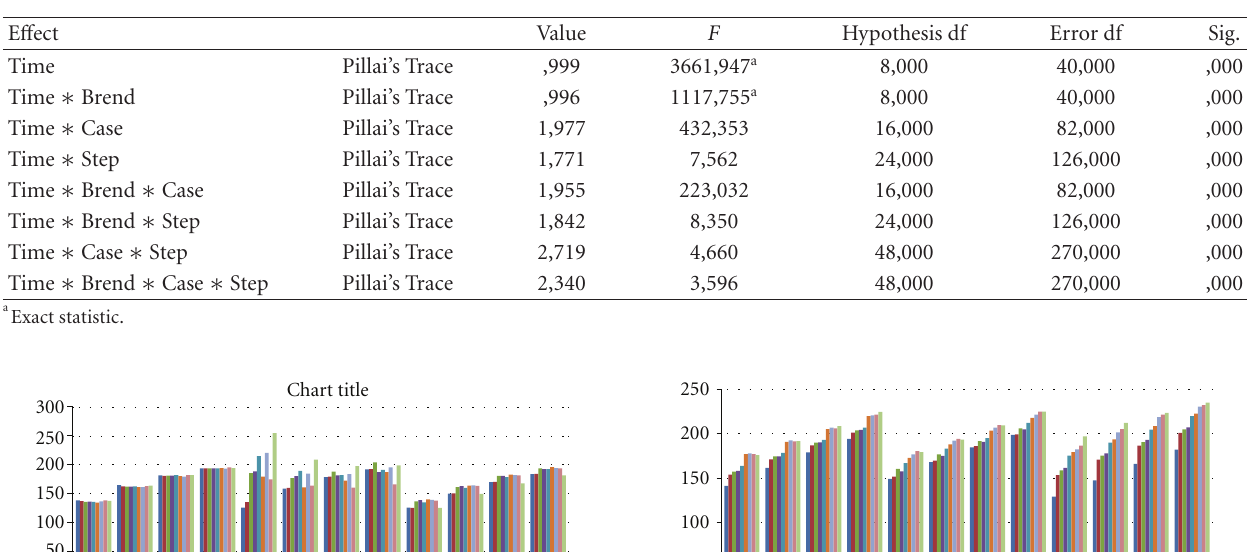
Table 3: Multivariate test results based on four factor repeated measures ANOVA for changes in MGVs.